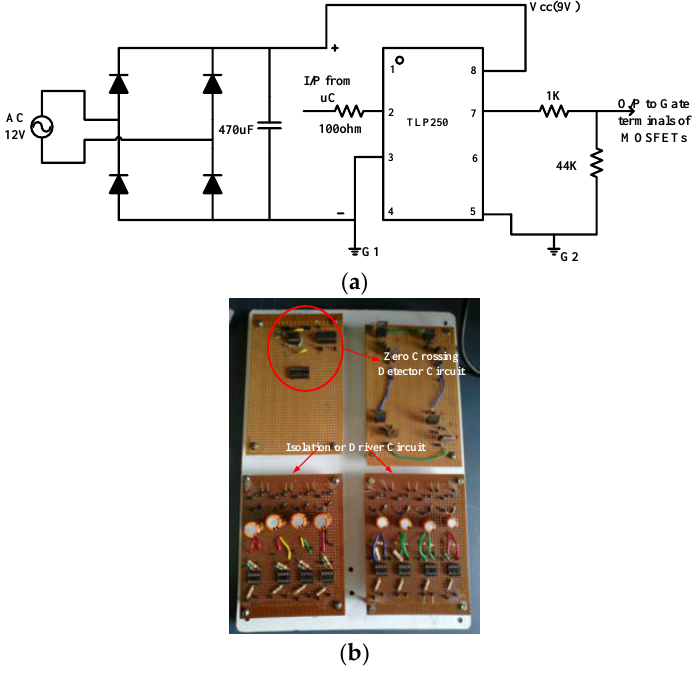
Figure 15. ( a ) Circuit diagram and its ( b ) experimental setup of isolation or driver circuit.